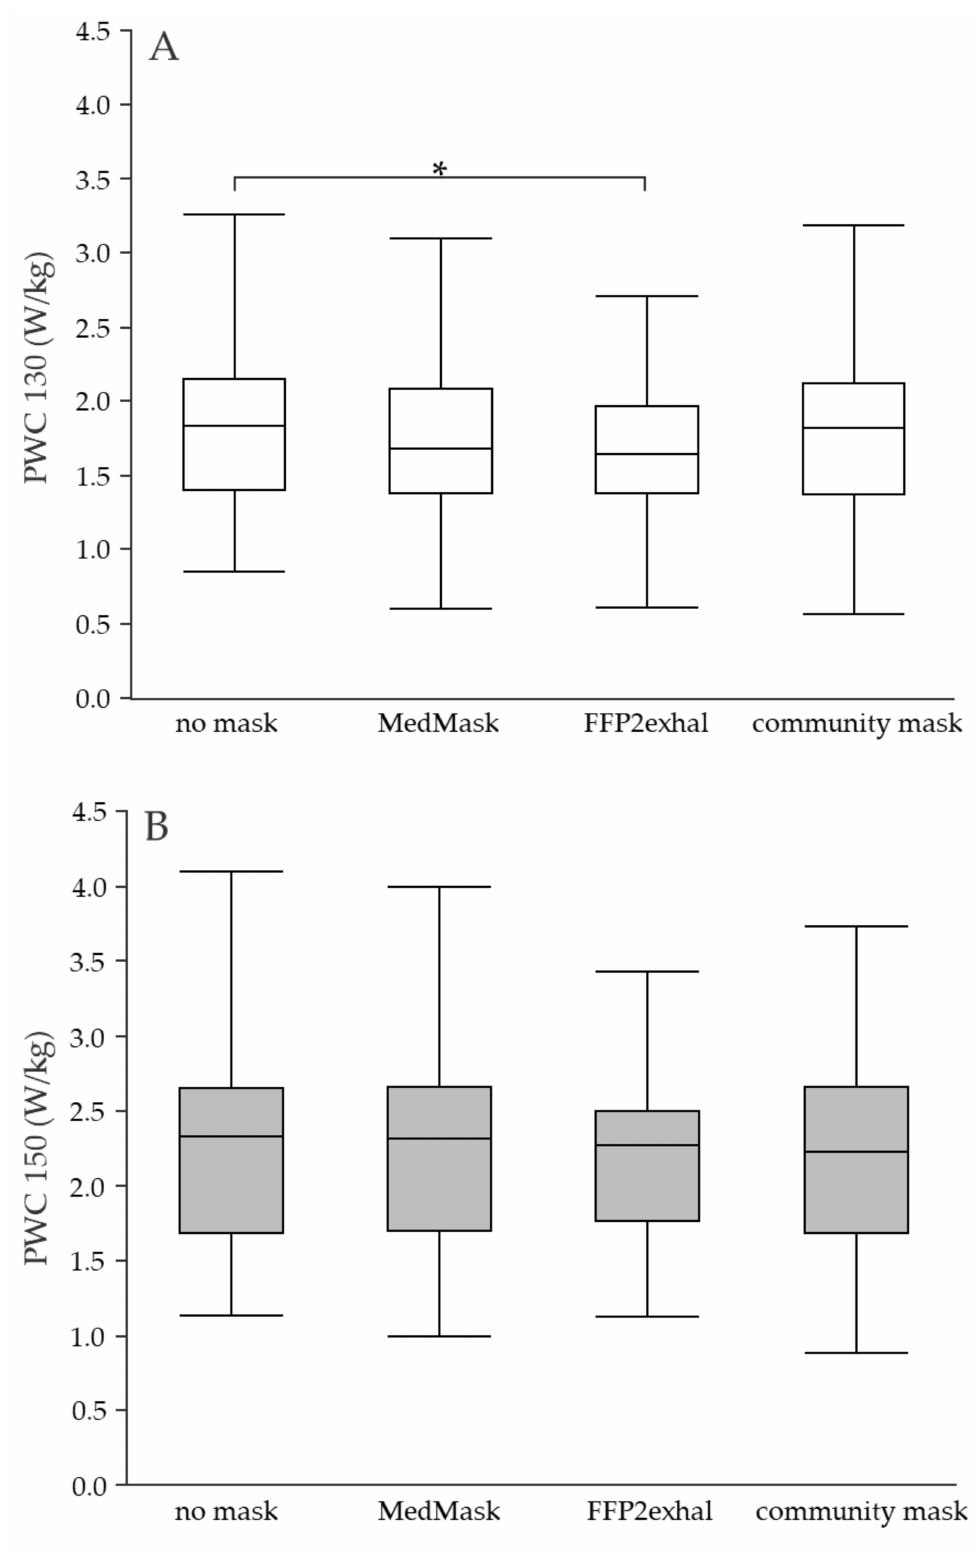
Figure 2. ( A , B ) Physical working capacity at the heart rate of 130 and 150 beats per minute using different face masks. Grey shaded boxplots represent the physical working capacity at the heart rate of 150 beats per minute. Asterisks indicate statistically significant differences (Bonferroni corrected p < 0.003). PWC, physical working capacity; MedMask, medical face mask; FFP2exhal, filtering facepiece with exhalation